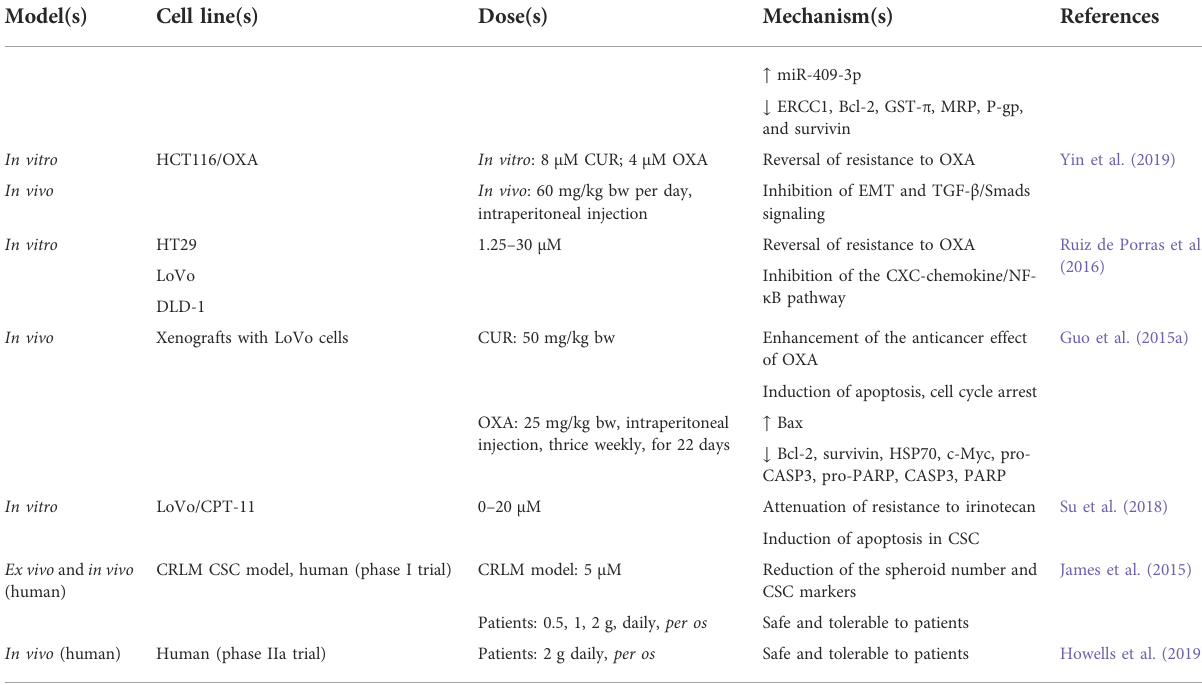
TABLE 2 ( Continued ) Pharmacological mechanism underlying the effects of curcumin on colorectal